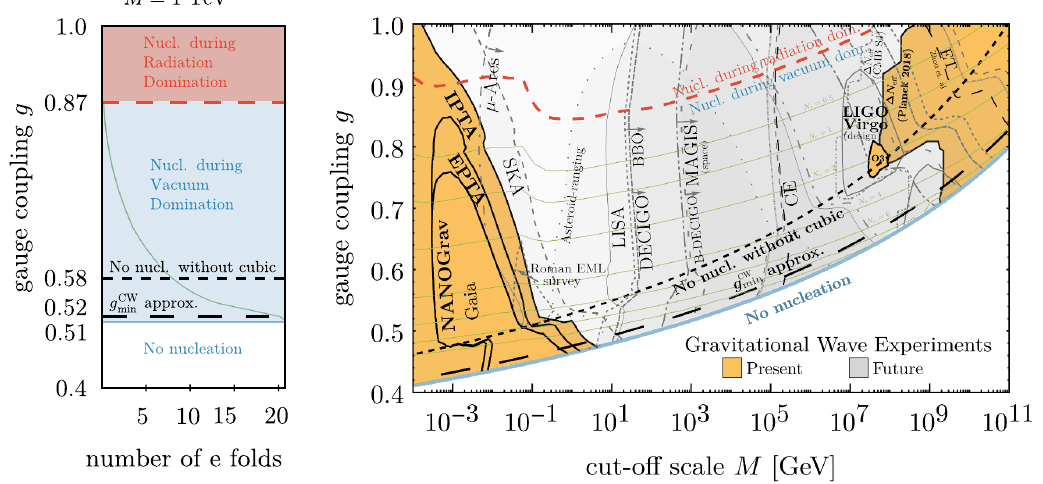
Figure 2 . The supercooling window for a classically scale invariant theory at weak coupling. As discussed in section 3.1 we take the CW model as a reference. Below the solid blue no nucleation is possible while above the dashed red line the transition occurs in radiation domination. The green lines indicate the number of of e-fold of inflation. The black dashed line shows how the approximation in eq. (3.12) compares to the full numerical result. The black dotted line shows how the boundary gets modified neglecting the thermal cubic. Left : fixing M = 1 TeV supercooled PTs require g to be in the range 0 . 51 < g < 0 . 87 . For g < 0 . 58 the nucleation is controlled by the thermally generated cubic in eq. (3.5) as detailed in eq. (3.12). For g < 0 . 53 daisies corrections become important as shown in eq. (3.13). For g < 0 . 51 the transition never completes and the universe remains in a state of eternal inflation. For g > 0 . 87 the transition completes in radiation domination. For g > 1 the perturbative control of the theory is lost. Right : summary of the current probes (yellow) and the future reach of the many proposed experiments (shades of gray) . See appendix C for a review. The lower boundary of the supercooling window is showed as a function of the cut-off scale M